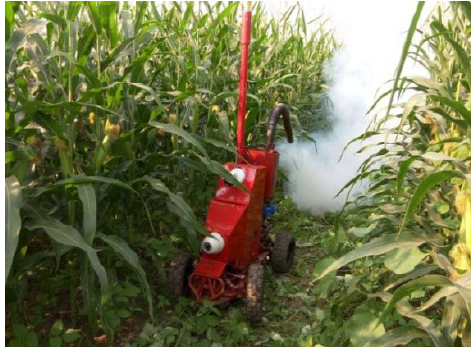
Figure 12. Testing of fogging machine in the field.